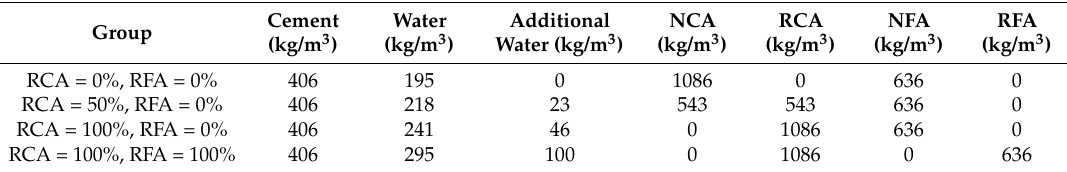
Table 2. Mix proportions of the concrete.